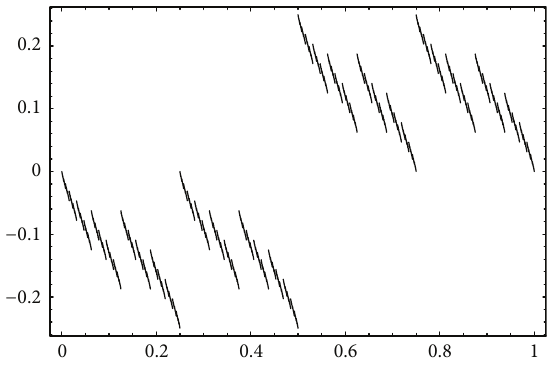
Figure 1: The self-affine set in Example